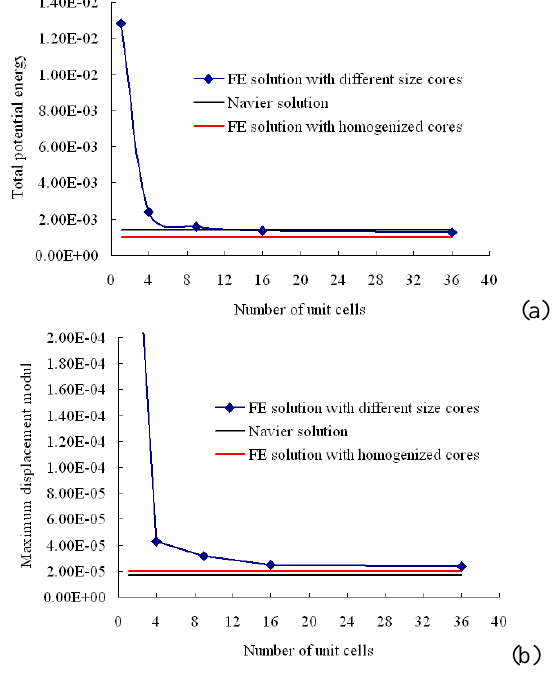
m dis- Fig.10. (a) Total potential energy and (b)